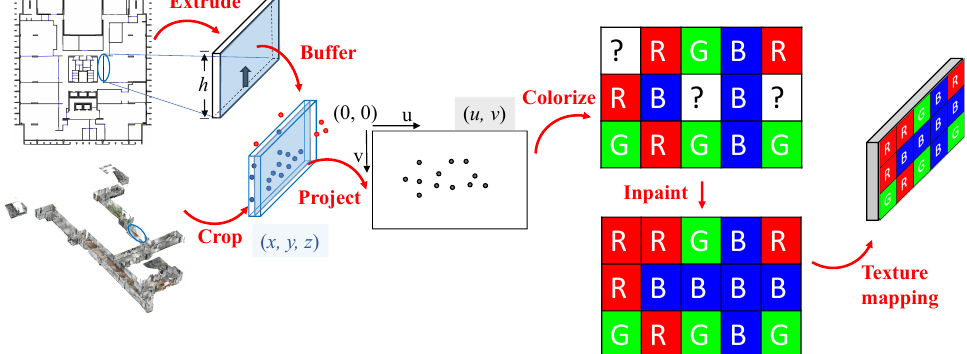
Figure 6. Generating and texturing DTB from the point clouds and CAD drawings. The points cropped out were then projected onto the face, i.e., converting their 3D coordinates ( x , y , z ) into the 2D plane coordinates ( u , v ) . The u - v coordinates were then discretized into the column and row indices on the texture image of this face. Then the corresponding image pixels were colorized with the projected point colors. Since not all image pixels could be projected by points, there were ‘holes’ on this image. Therefore, we applied the inpainting [65] and default colorizing to generate the final complete texture images. Once generated, the texture images could be mapped onto the face by aligning the image corners to the face